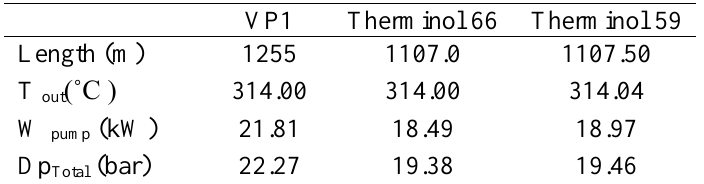
Table 4. Comparison of solar field parameters for different thermal oils considering outlet temperature of 315°C for all the